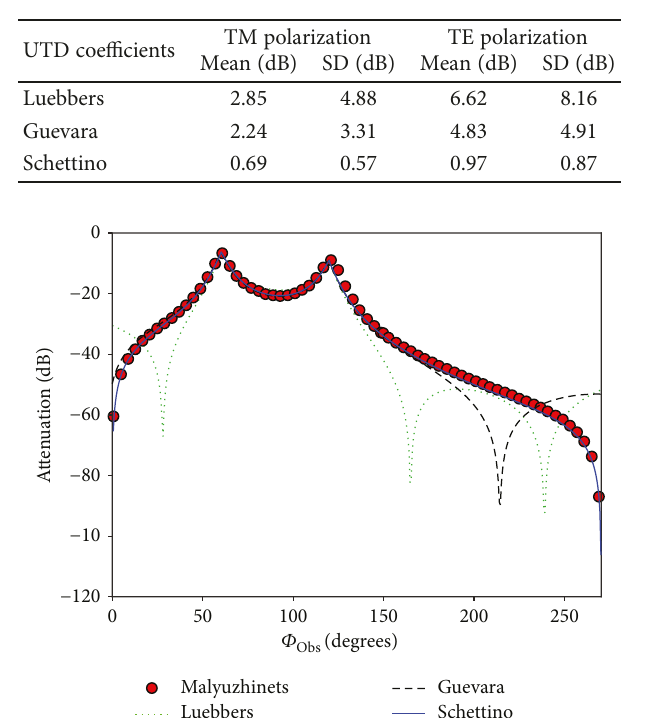
Figure 6: Attenuation of the di ff racted fi eld for TE polarization around the wedge; incidence on both faces at ϕ i = 3 π /4 . Table 2: Statistics for incidence on both faces.